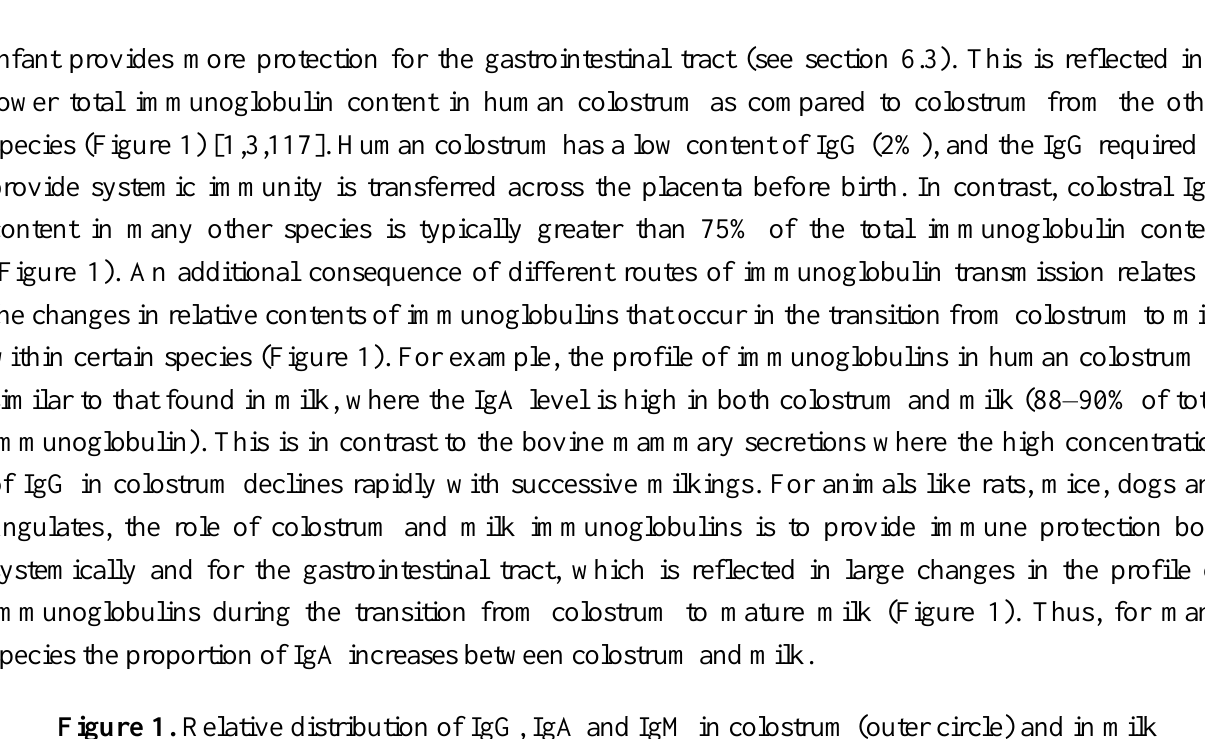
Figure 1. Relative distribution of IgG, IgA and IgM in colostrum (outer circle) and in milk (inner circle) of five species. The relative size of the circles represents the overall concentration of total immunoglobulins found among the species and the concentrations in colostrum vs. milk. Data compiled and calculated from: cow and sheep [1]; human and pig [3]; and horse